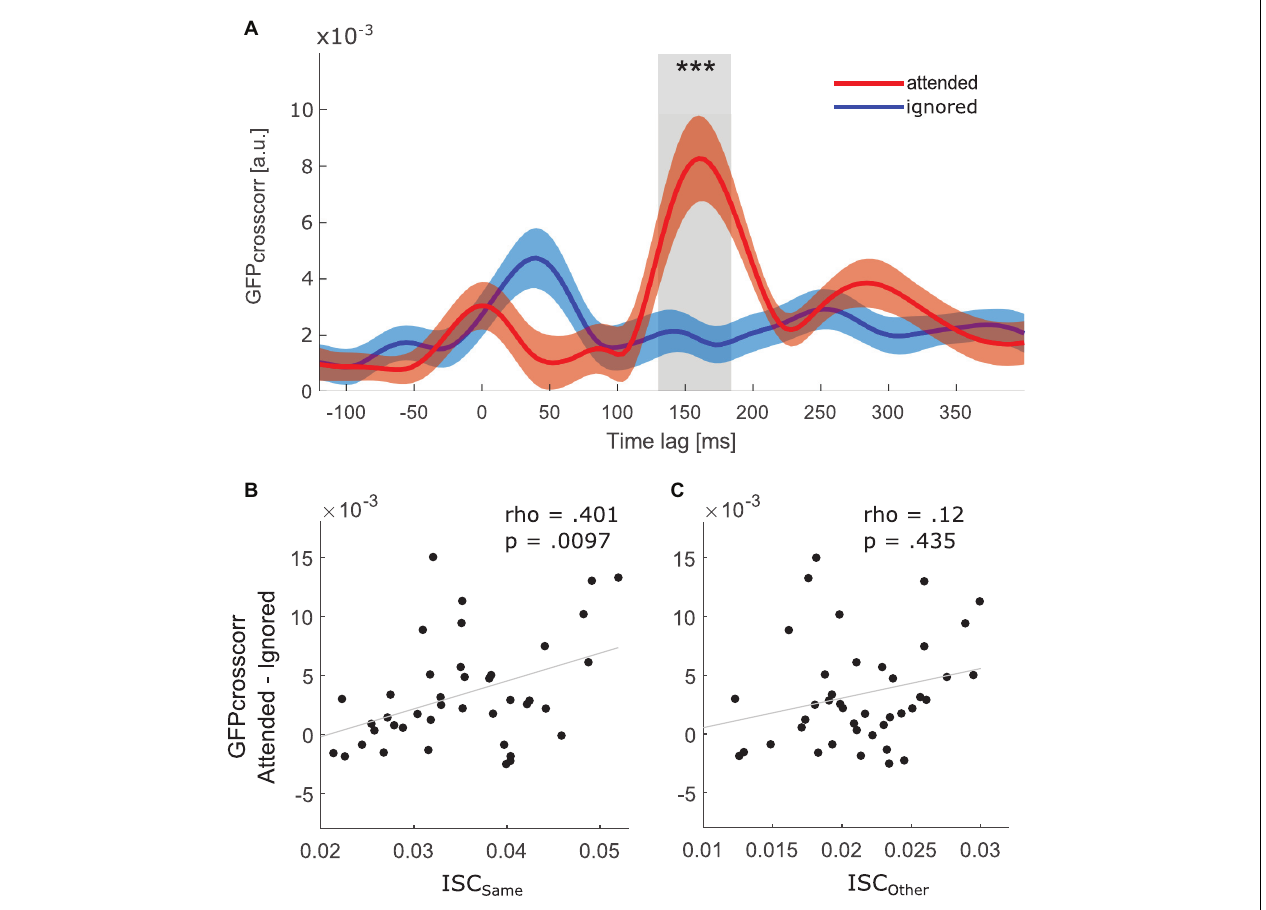
FIGURE 4 | (A) Grand average global field power (GFP) of cross-correlation between the EEG signal and the attended (red) and ignored (blue) speech envelope after averaging over all epochs and participants. Red and blue shaded areas show the confidence interval of the respective function. *** indicates a difference ( p < 0.001) between the two functions in the time window of P2 crosscorr , i.e., from 130 to 184 ms time lag. (Bottom) Correlation between ISC and selective attention effect on speech envelope tracking. Attentional modulation of the speech envelope tracking is defined as the difference between the attended and ignored GFP crosscorr in the P2 crosscorr time window. Each datapoint represents one participant. (B) Correlation with participant’s ISC same score. (C) Correlation with participant’s ISC other score.